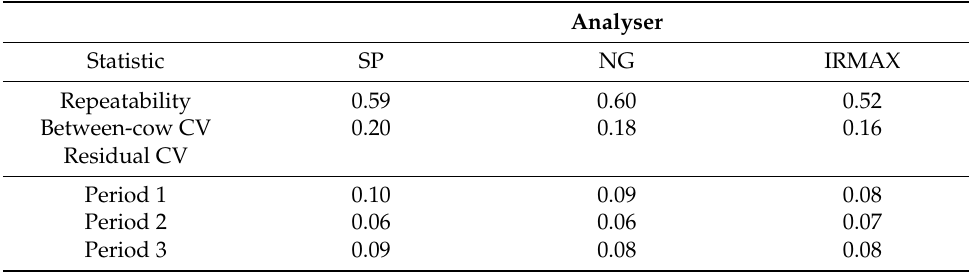
Table 3. Repeatability of methane measurements and coefficients of variation (CV) for three gas